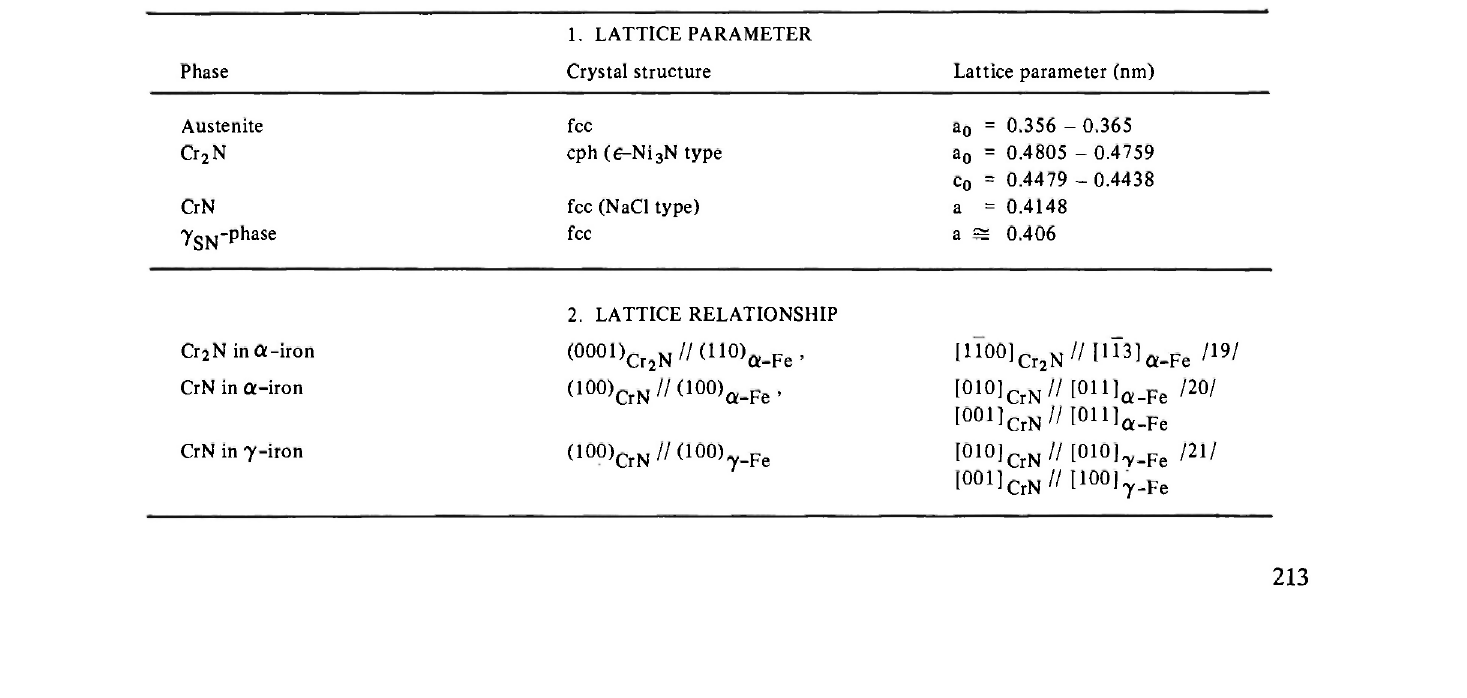
Lattice parameters of phases and lattice relationship between chromium nitrides and steel phases 1. LATTICE Phase